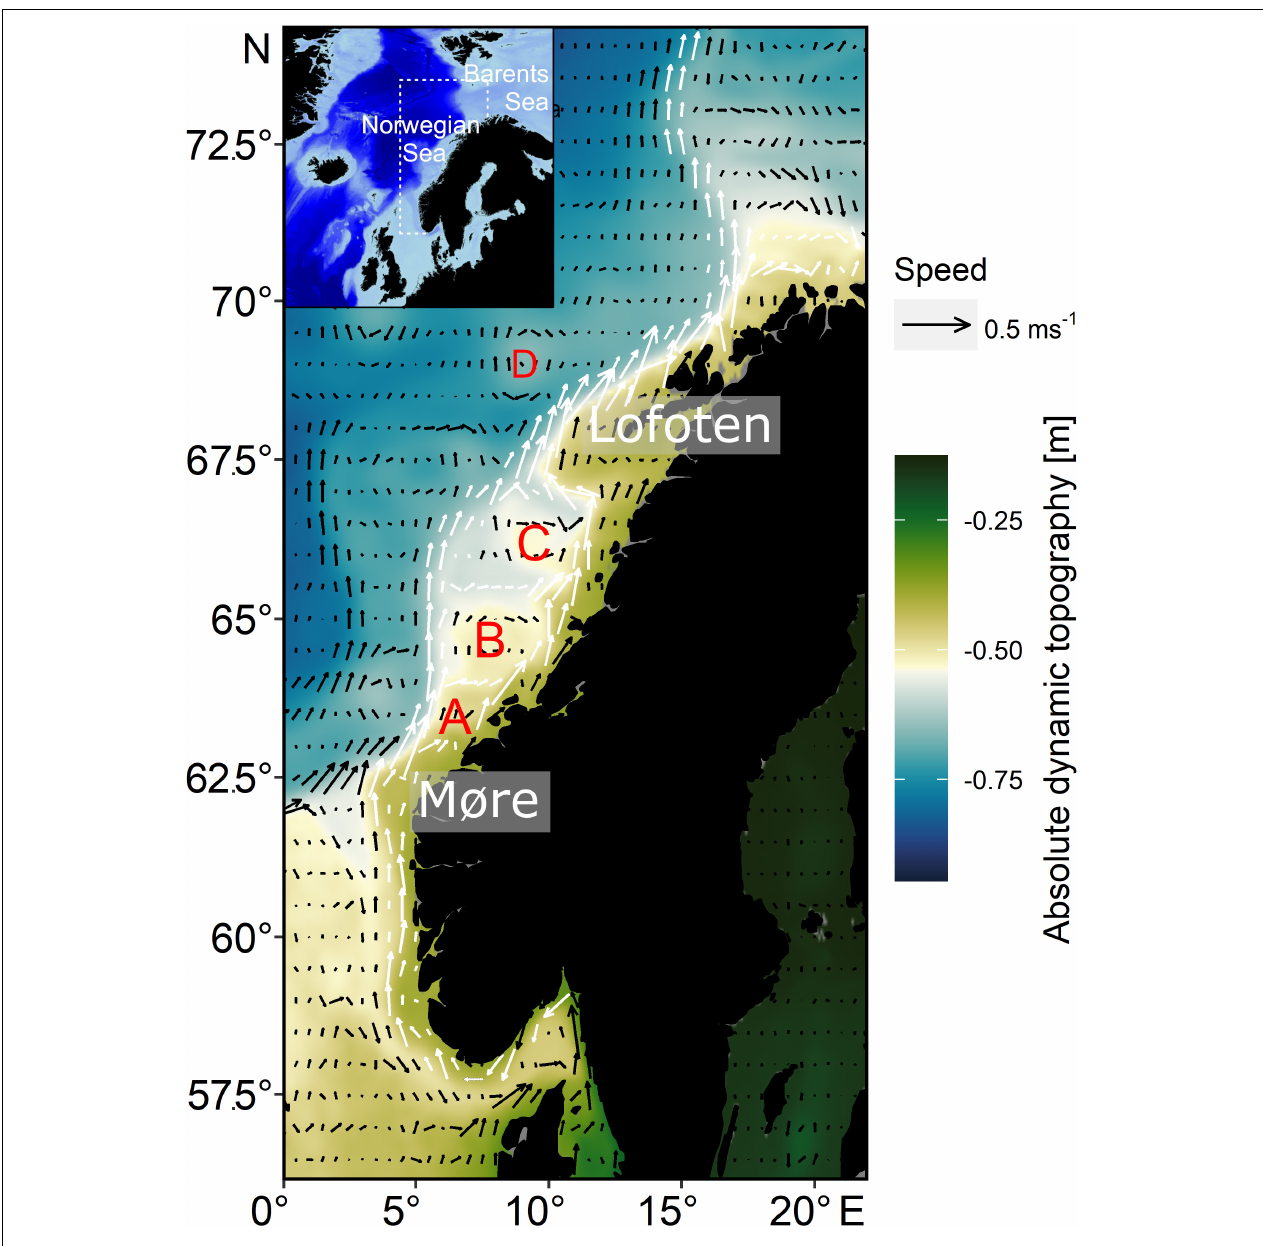
FIGURE 1 | Study area with arrows illustrating currents along the Norwegian coast during the main larval drift season in March–April (average current strength and direction from 1993 to 2016) superimposed on absolute dynamic topography (average from 1993 to 2016); the main branches of the Norwegian Coastal Current are marked with white arrows; current data are based on GLORYS12V1 also used as hydrodynamic dataset for the larval drift simulations; stationary mesoscale eddies are mainly observed in A (Frøya Bank), B (Halten Bank), and C (Træna Bank); D depicts a mobile eddy that typically forms off